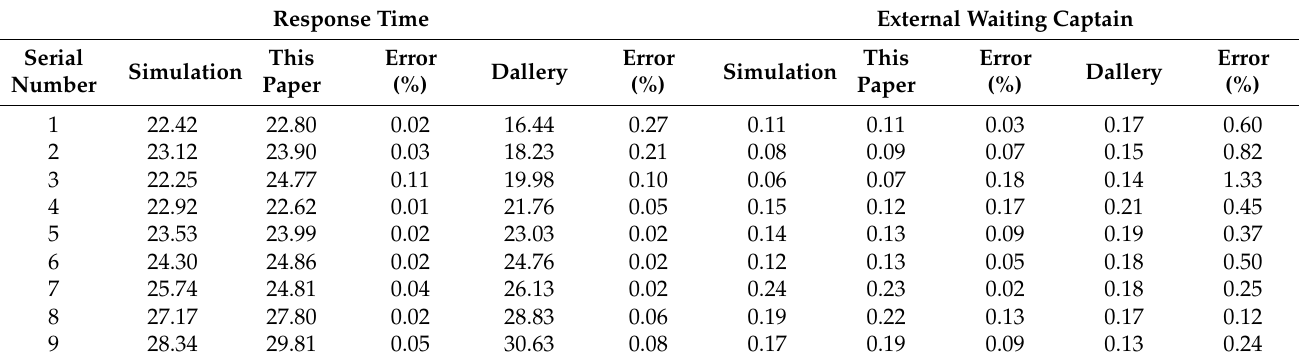
Table 8. Comparison of model data and error